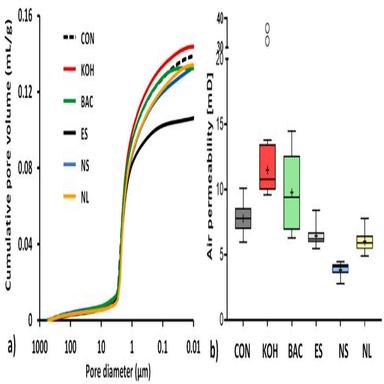
Cumulative pore volume curves (a) and boxplot summarizing air permeability (b) of untreated (CON) and consolidated earthen mock-ups (Each box extends from 25th to 75th percentiles, whiskers indicate lower/higher absolute values, central line and cross indicate median and average values, respectively. Empty circles indicate outliers).